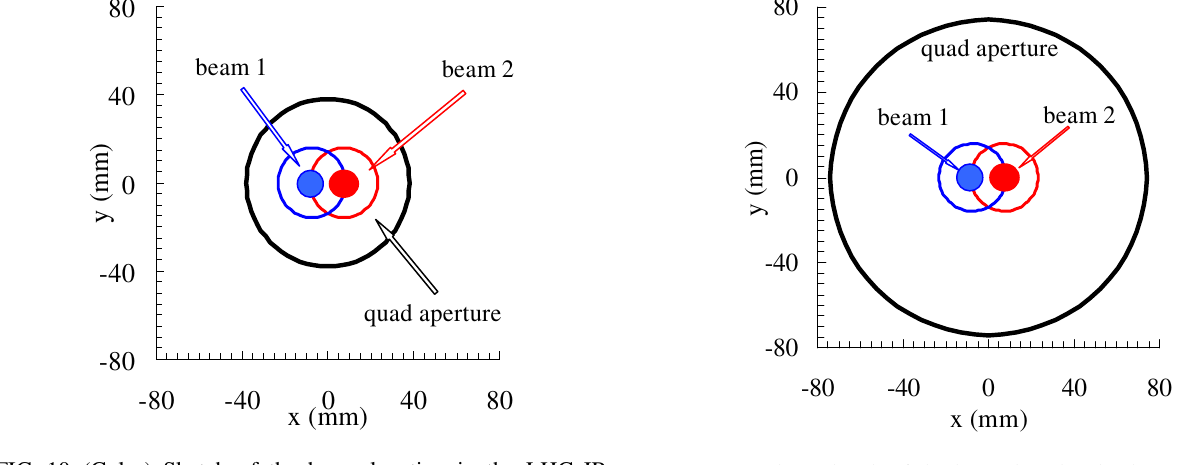
FIG. 10. (Color) Sketch of the beam location in the LHC IR quadrupole, nominal values ( (cid:1) (cid:1) (cid:5) 55 cm